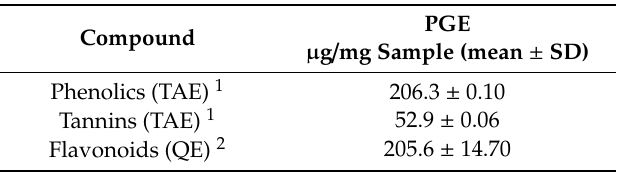
Table 1. Amounts of total phenolics, tannins, and flavonoids in the ethyl acetate extract by Soxhlet of the waste peel of Punica granatum L. var. Dente di Cavallo DC2 (PGE) ( n =